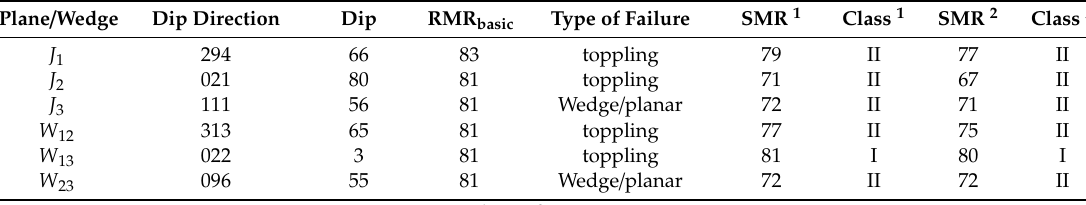
Table 5. Evaluation of SMR parameters of the discontinuity sets and formed wedges at sector 2. Plane / Wedge